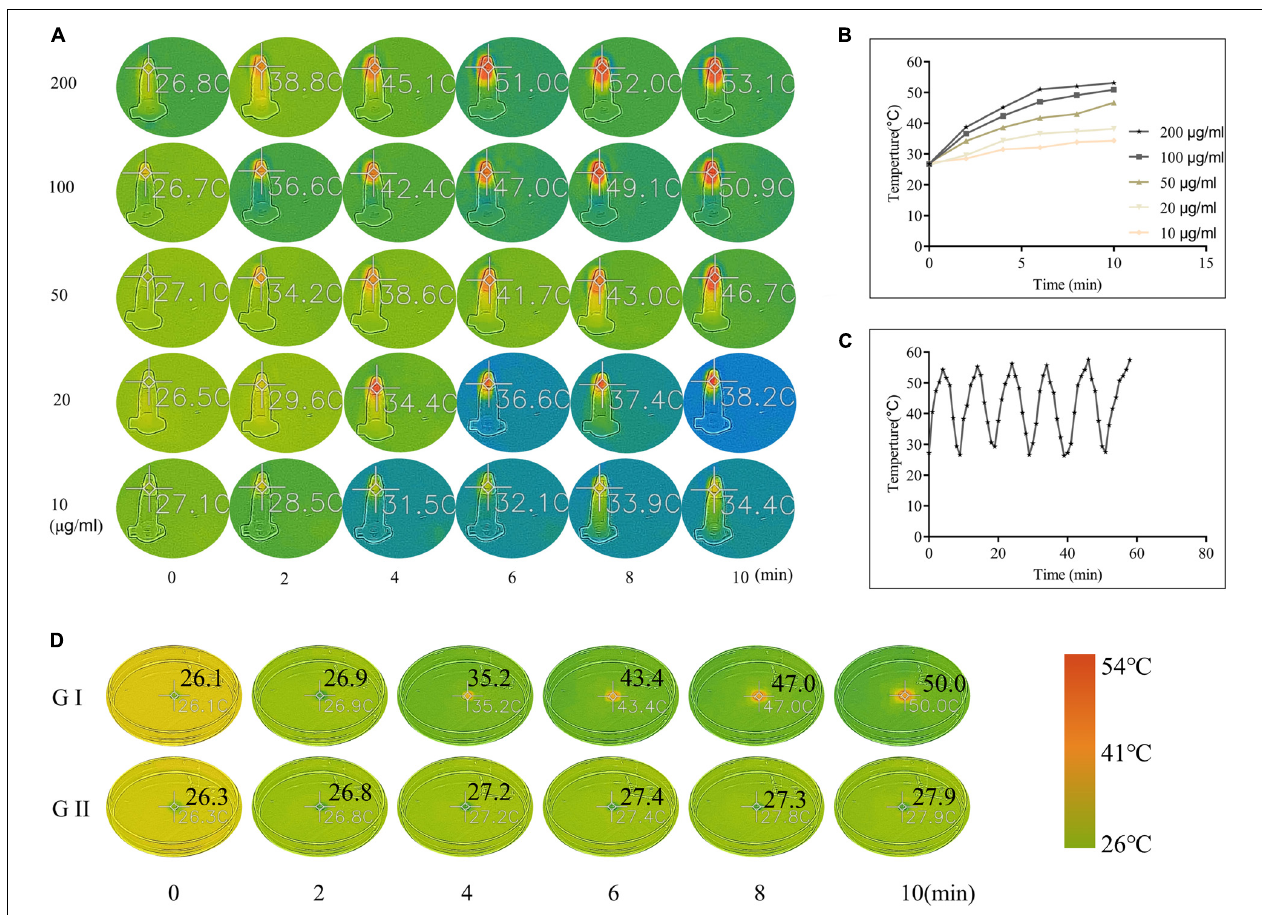
FIGURE 4 | (A,B) Photothermal images and corresponding heating curves of CuS NPs with different concentrations upon 808 nm laser exposure. (C) The heating curve of the CuS NPs upon repeated 808 nm irradiation and followed natural cooling. (D) Photothermal images of CuS/HA (GI) and blank hydrogels (GII) upon 808 nm laser exposure. ( A and D share the same color